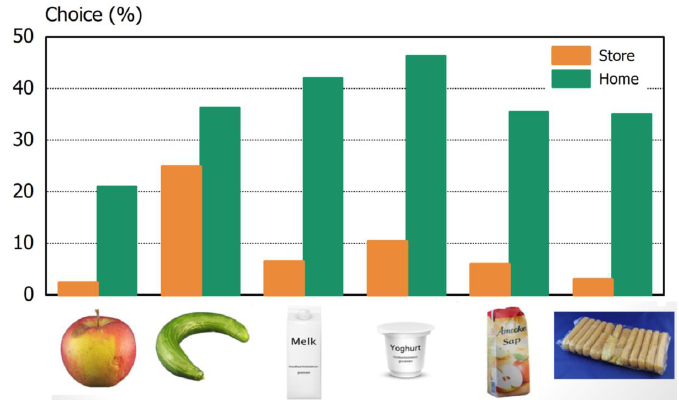
Figure 2. Choice of the suboptimal food differs between the supermarket- and the home-setting ( n = 4214). Each pair of bars is associated with the respective product images